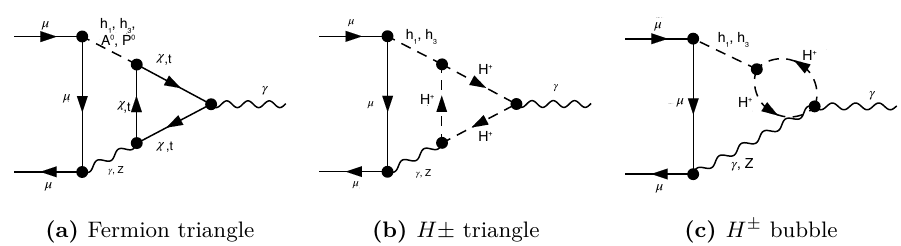
Figure 7. Dominant diagrams contributing to muon g − 2 at the two loop